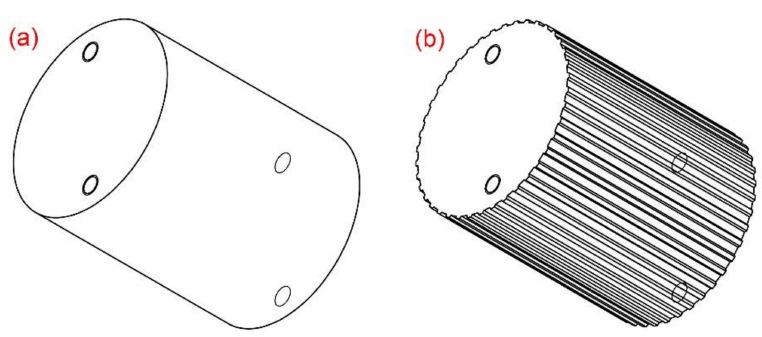
Figure 18. The measurement models: ( a ) O-specimen model; ( b ) TS-specimen model.